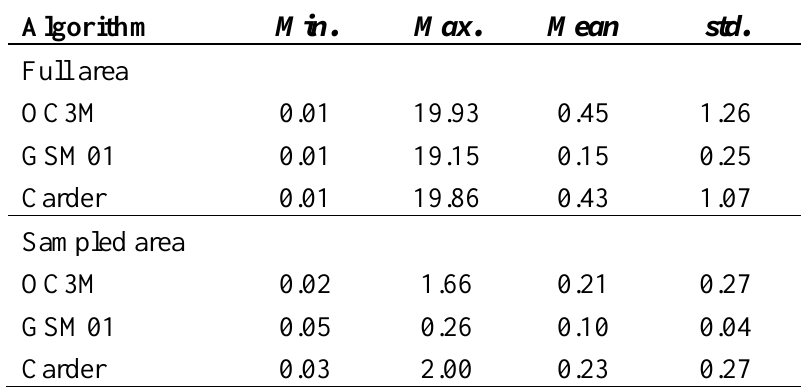
Table 2. Comparison between histograms of MODIS chlorophyll concentration estimates obtained with 3 algorithms for the full image area and for the in situ sampled area (mg/m 3